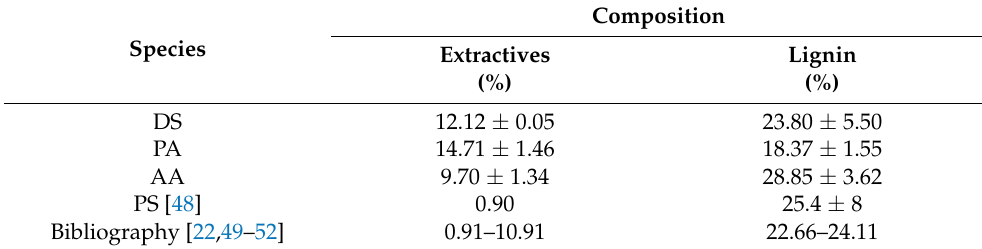
Figure 4. Representation of the mass loss results EN 113 and EN 335 of the bamboo specimens (DS, PA and AA) and of the control sample (PS). PA and AA) and of the control sample (PS). Table 5. Chemical composition of DS, PA, and AA